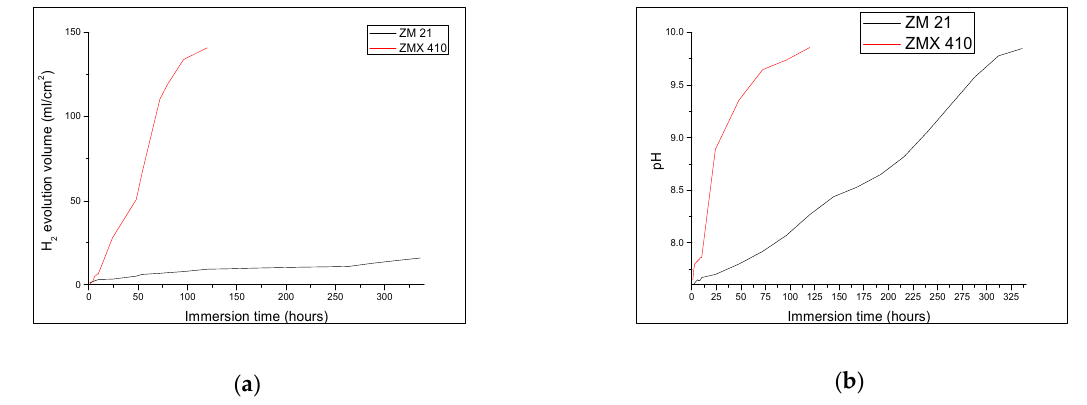
Figure 10. Behaviour of samples ZM21 and ZMX410 during immersion test: ( a ) The hydrogen release values registered for ZM21 and ZMX410 alloys; ( b ) pH values registered for ZM21 and ZMX410 alloys. Corrosion rates for the ZM21 and ZMX410 samples, calculated according to the Equation (5), are presented in Table 2. Table 2. Corrosion rate of ZM21 and ZMX410 samples during the immersion test in SBF. Time (h)